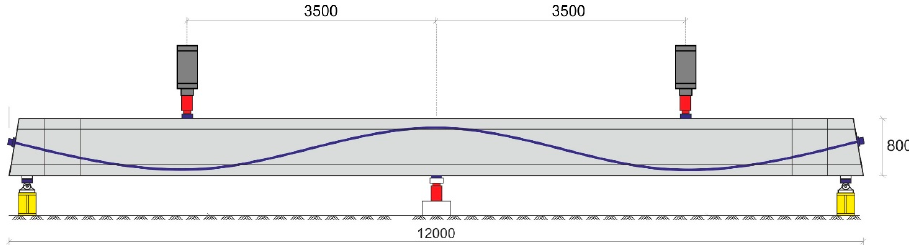
Figure 9. Sketch of load test setup for girder DLT 1.3 (dimensions in mm). Blue line: tendon duct.